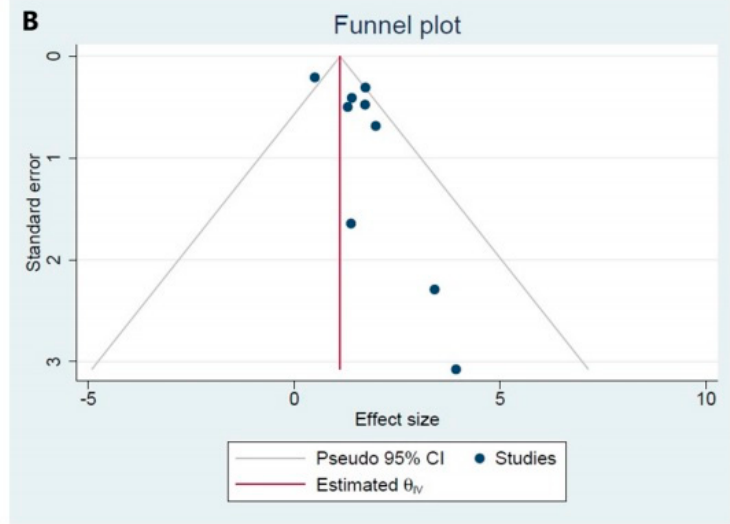
Figure 10. ( A ) Funnel plot for the estimation of potential publication bias. Begg’s funnel plot for disease-free survival; and ( B ) funnel plot for the estimation of potential publication bias. Begg’s funnel plot for overall